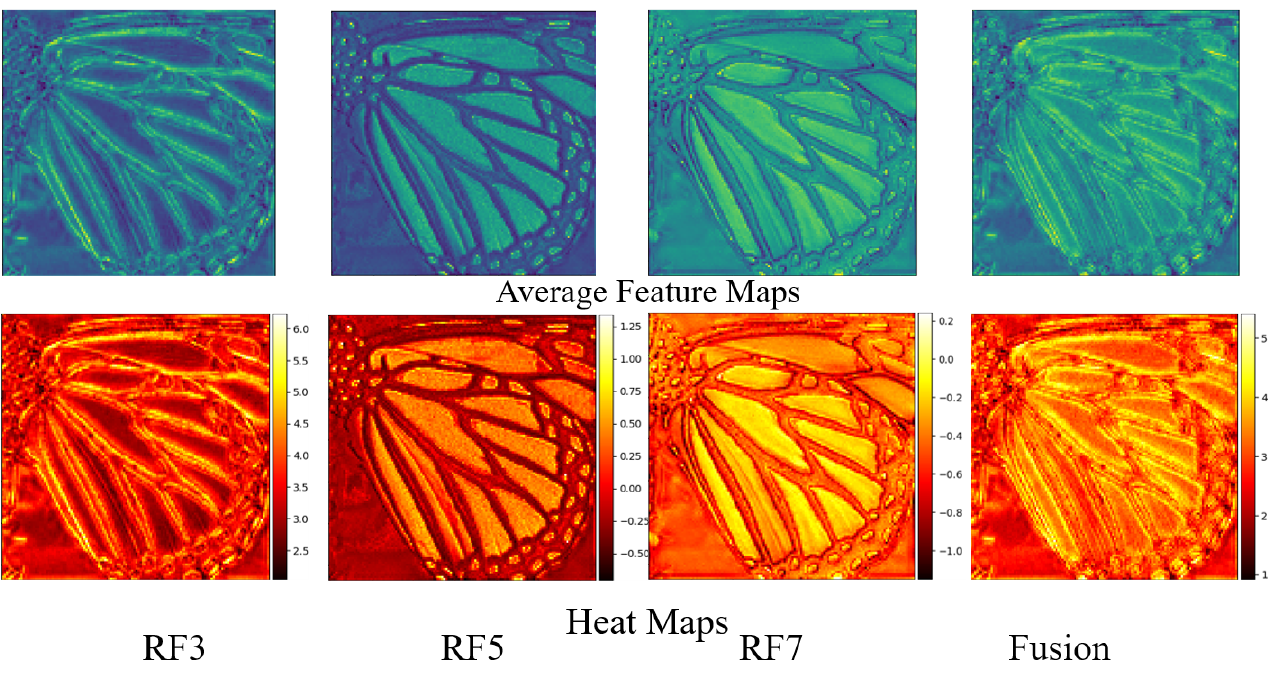
Figure 6. Visual qualitative comparison of average feature maps and average heat maps, via Local Multi-scale